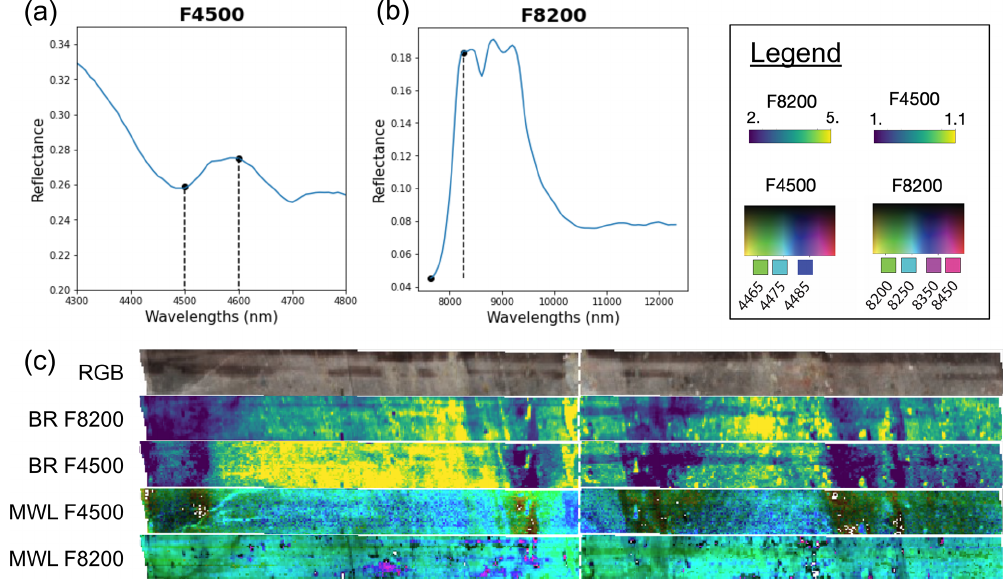
Figure 5. Distribution of the quartz-related spectral features in the Kupferschiefer cores. (a) Band ratio for F4500; (b) band ratio for F8200; (c) RGB, F8200, and F4500 maps for drill hole 136 (depth from right to left is 1053.5–1055.5m,